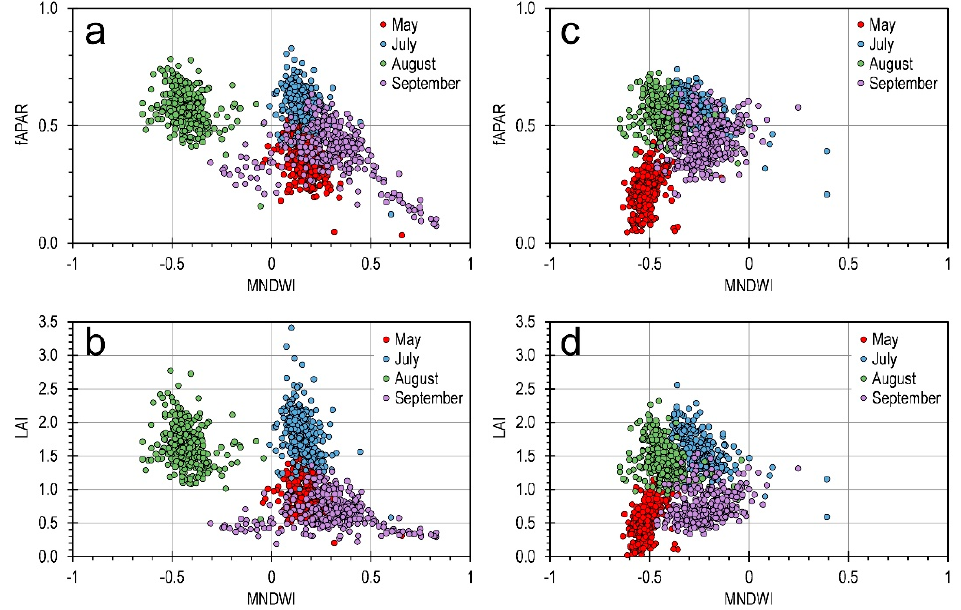
Figure 9. Comparison of Coniferous class leaf area index (LAI) and absorbed photosynthetically available radiation (fAPAR) vs. Modified Normalized Difference Water Index (MDNWI) indices for the 2018 ( a , b ) and 2019 ( c , d ) growing seasons.